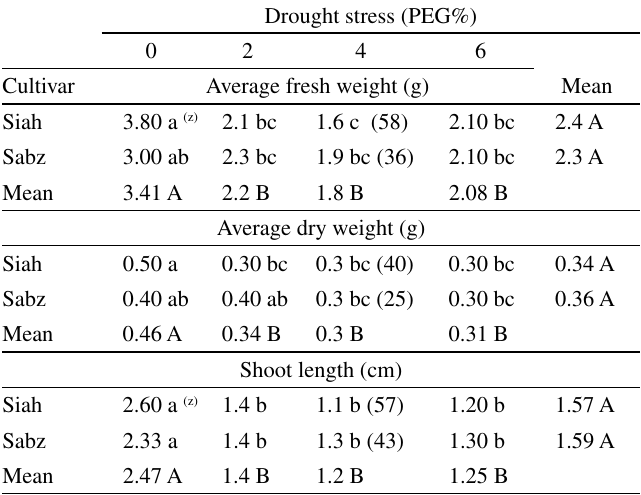
Table 1 - Interaction of water stress and cultivar on micro-shoot length, fresh and dry weight